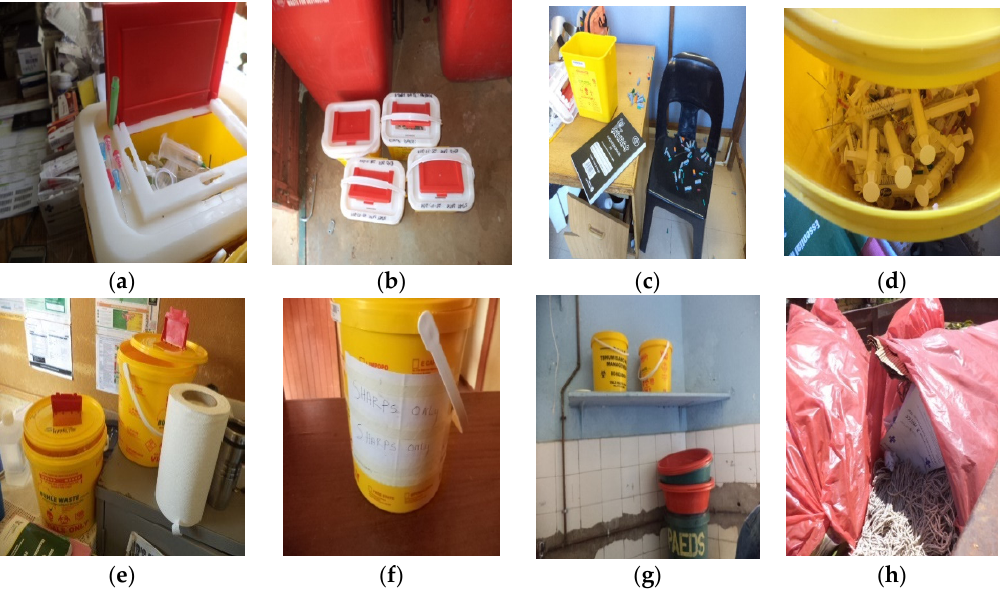
Figure 4. Photos taken by researcher during field work showing: careless dropping of sharps waste on top of the waste bin ( a ); improper closure of the lids of containers for sharps waste ( b – e ); accidental spillage of sharps waste due to improper closure of the lid ( c ); a bin for temporary storage of vials waste, relabeled to be used for storage of sharps ( f ); temporary storage equipment being used as water containers in the bathroom ( g ) and inappropriate use of red liners for storage of general waste ( h ).